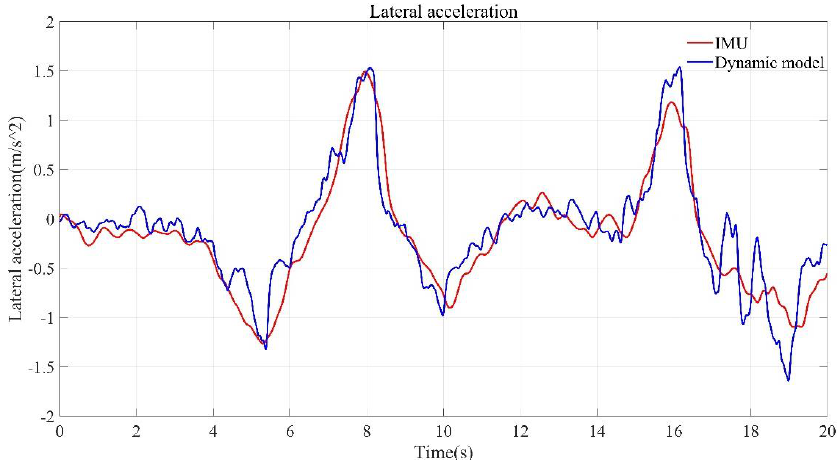
Figure 19. Comparison of the lateral acceleration results between the vehicle dynamics model using estimation results and the real vehicle test.